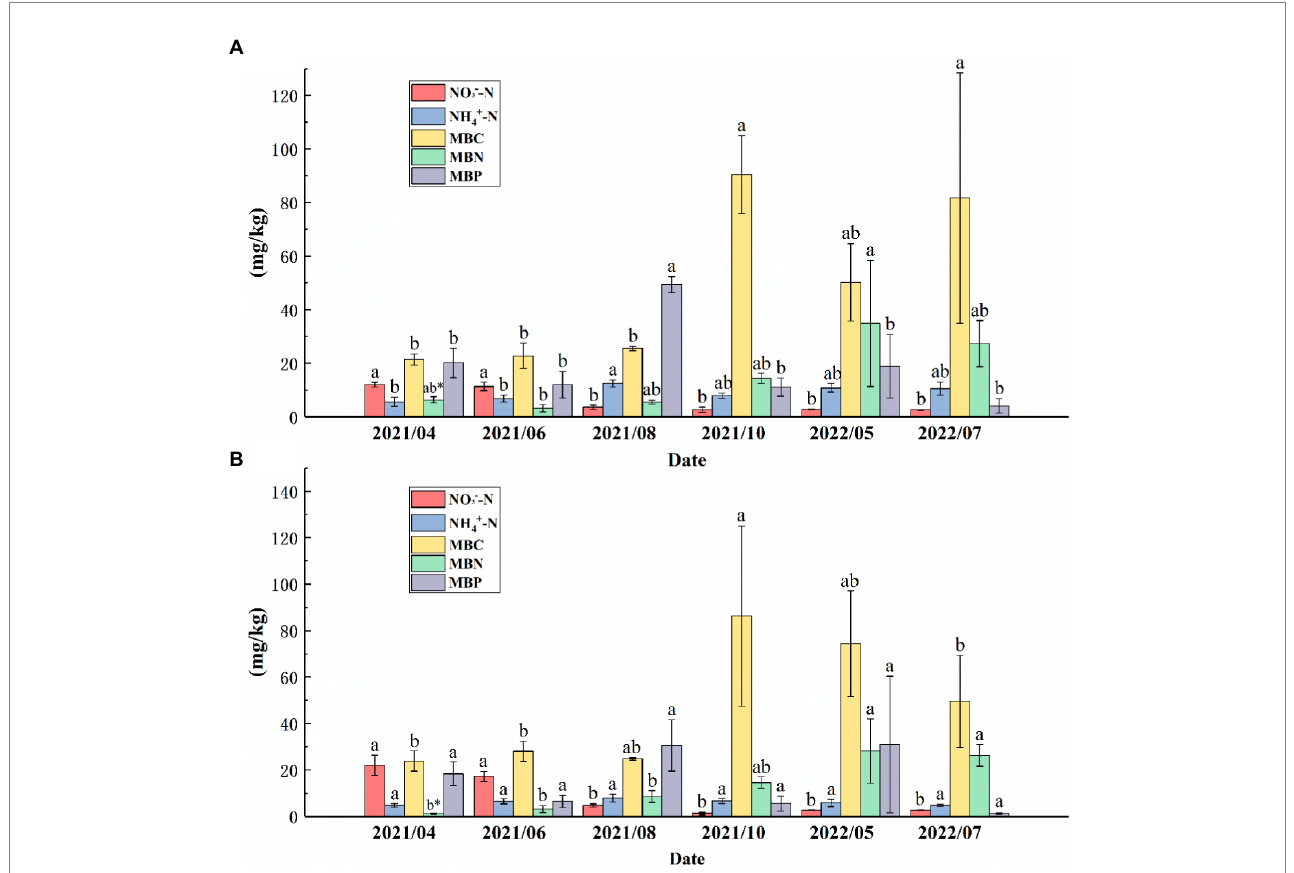
FIGURE 5 NH 4+ --N, NO 3 − --N, microbial biomass carbon (MBC), microbial biomass nitrogen (MBN), and microbial biomass phosphorus (MBP) contents in the (A) topsoil and (B) subsoil from April 2021 to July 2022. Different letters indicate significant differences between months for the same variable ( p < 0.05). * indicates that the same variable in the same month is significantly different in different soil layers ( p < 0.01).